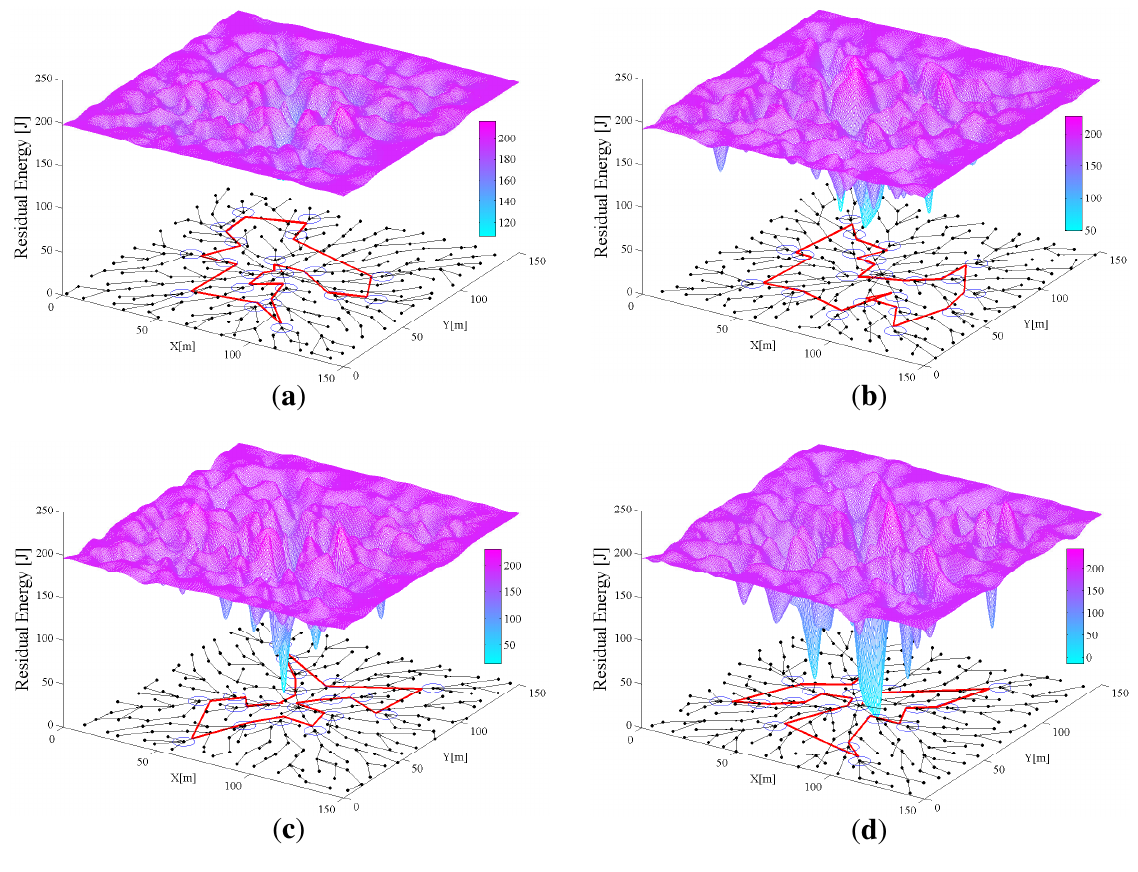
Figure 7. Distribution of network energy consumption with shortest path tree data gathering algorithm (SPT-DGA). The x − y plane shows the initial network topology generated by SPT-DGA. The 3D surface is fit to the x − y − z data points ( x − y is the 2D coordinate of a node; z is the residual energy of a node). ( a – d ) show the distribution of network energy consumption during the 10th, 50th, 90th and 104th rounds, respectively. ( a ) The distribution of network energy consumption with SPT-DGA during the 10th round; ( b ) the distribution of network energy consumption with SPT-DGA during the 50th round; ( c ) the distribution of network energy consumption with SPT-DGA during the 90th round; ( d ) the distribution of network energy consumption with SPT-DGA during the 104th